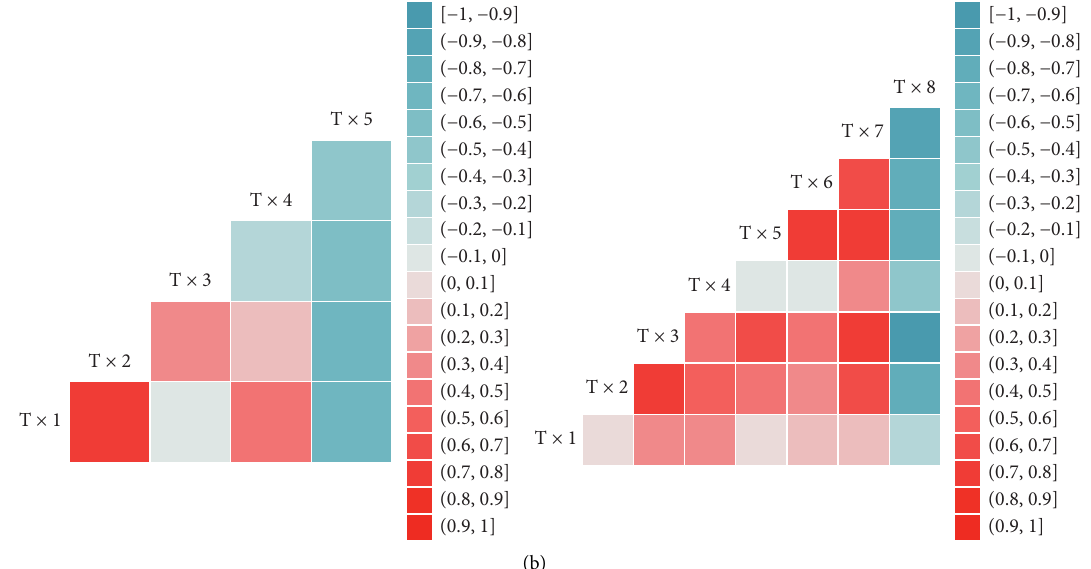
Figure 9: Correlation matrices to analyze the relationship between taxa for the subjects considered by Caporaso et al. (a) and simulated datasets (b),